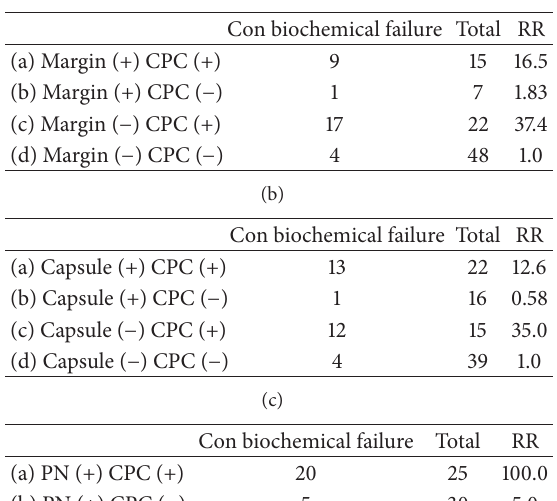
( − ), 17/22 versus 4/50 ( 𝑃 = 0.0001 Chi-squared) (Table 6). Comparing CPC (+) margin (+) with CPC (+) margin ( − ) there was no significant difference ( 𝑃 = 0.16 chi-squared); similarly there was no difference between CPC ( − )